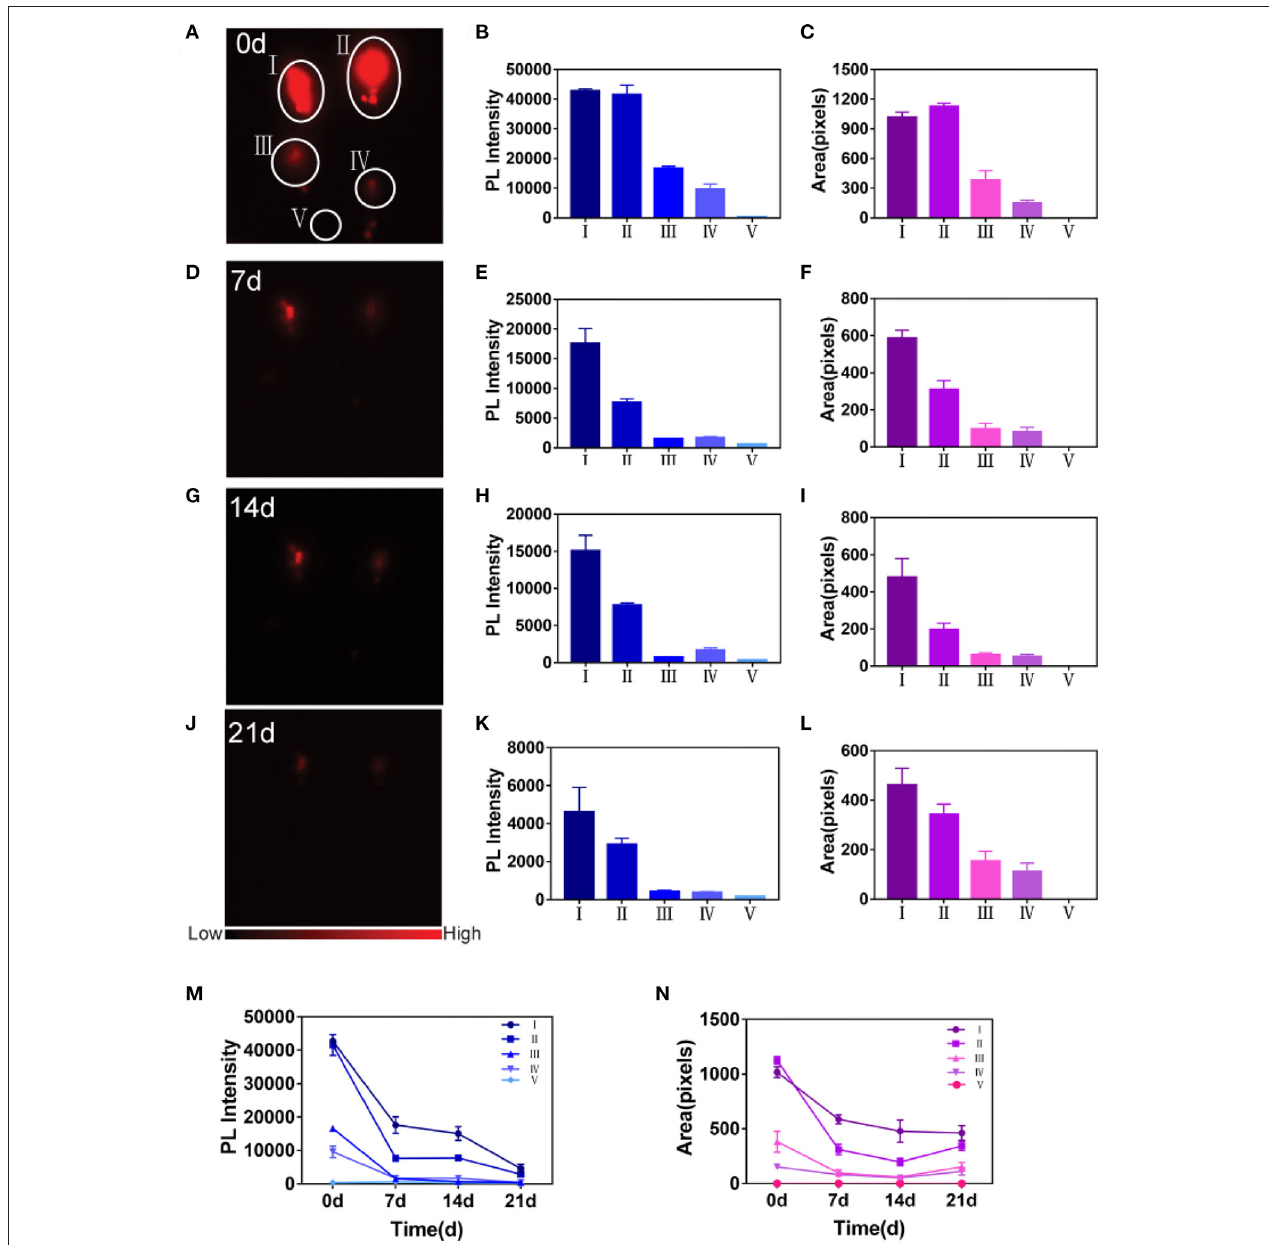
FIGURE 3 | Detection of sensitivity and stability of PbS QDs labeled ADSCs in vivo . (A,D,G,J) NIR-II imaging of PbS QDs labeled ADSCs (1 × 10 5 , 5 × 10 4 , 5 × 10 3 , and 5 × 10 2 cells) and PBS in vivo in a time course (0, 7, 14, and 21 d post-injection). (B,E,H,K) PL intensity measured from (A,D,G,J) . (C,F,I,L) Fluorescence area measured from (A,D,G,J) . (M) Longitudinal comparison of PL intensity measured from (A,D,G,J) . (N) Longitudinal comparison of fluorescence area measured from (A,D,G,J) .